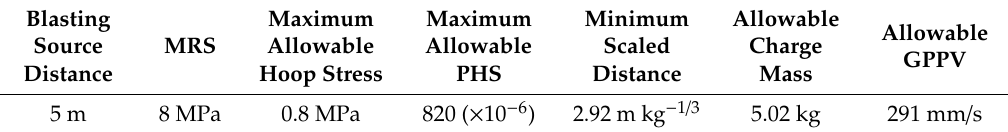
Table 5. The calculation parameters and results.